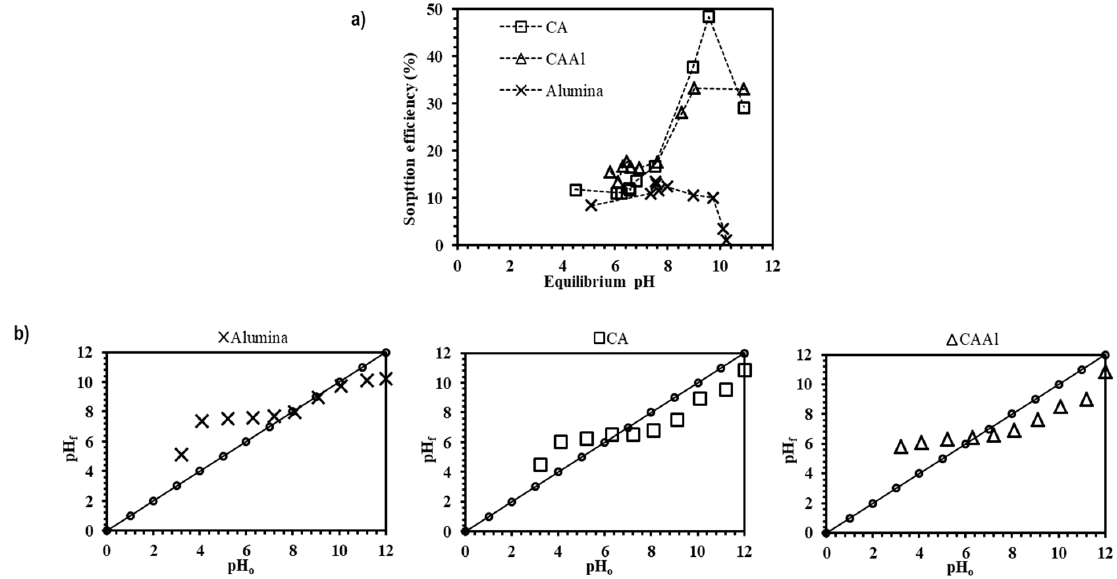
Figure 2. Influence of pH on boron removal. ( a ) Removal performances using alumina, CA and CAAl. materials ( b ) variation in pH (pH 0 : 3–12, [B]initial = 50 mg L − 1 , V = 100 mL, T room, 1 atm).